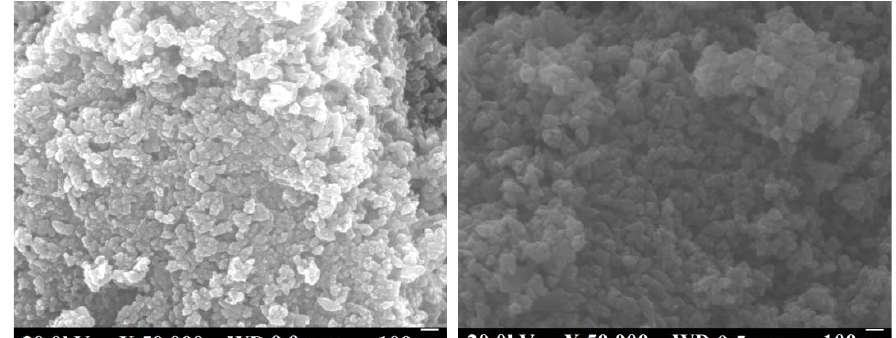
Figure 6. SEM images of zinc oxide synthesized at 50 °C with a flow rate of 200 mL/min ( left ) and with a flow rate of 250 mL/min ( right